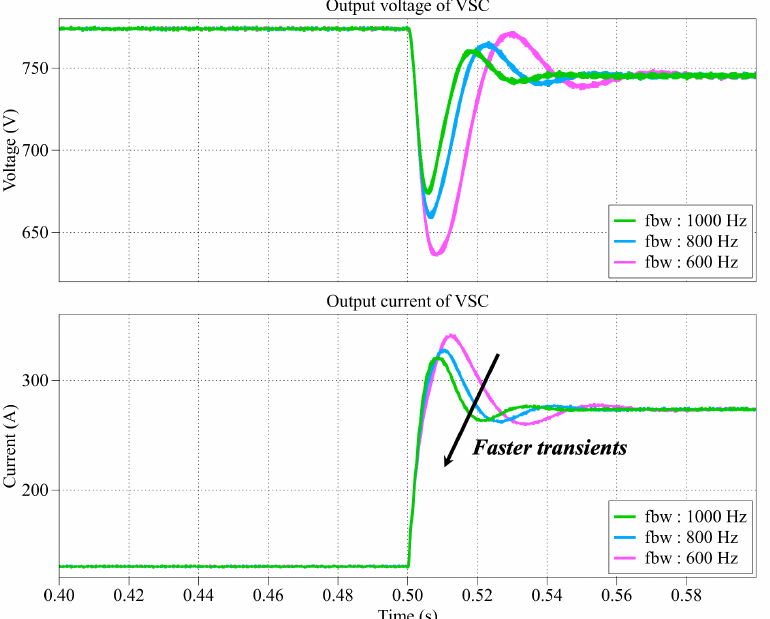
Figure 10. The transients as load steps from 50 kW to 100 kW with different bandwidth of current